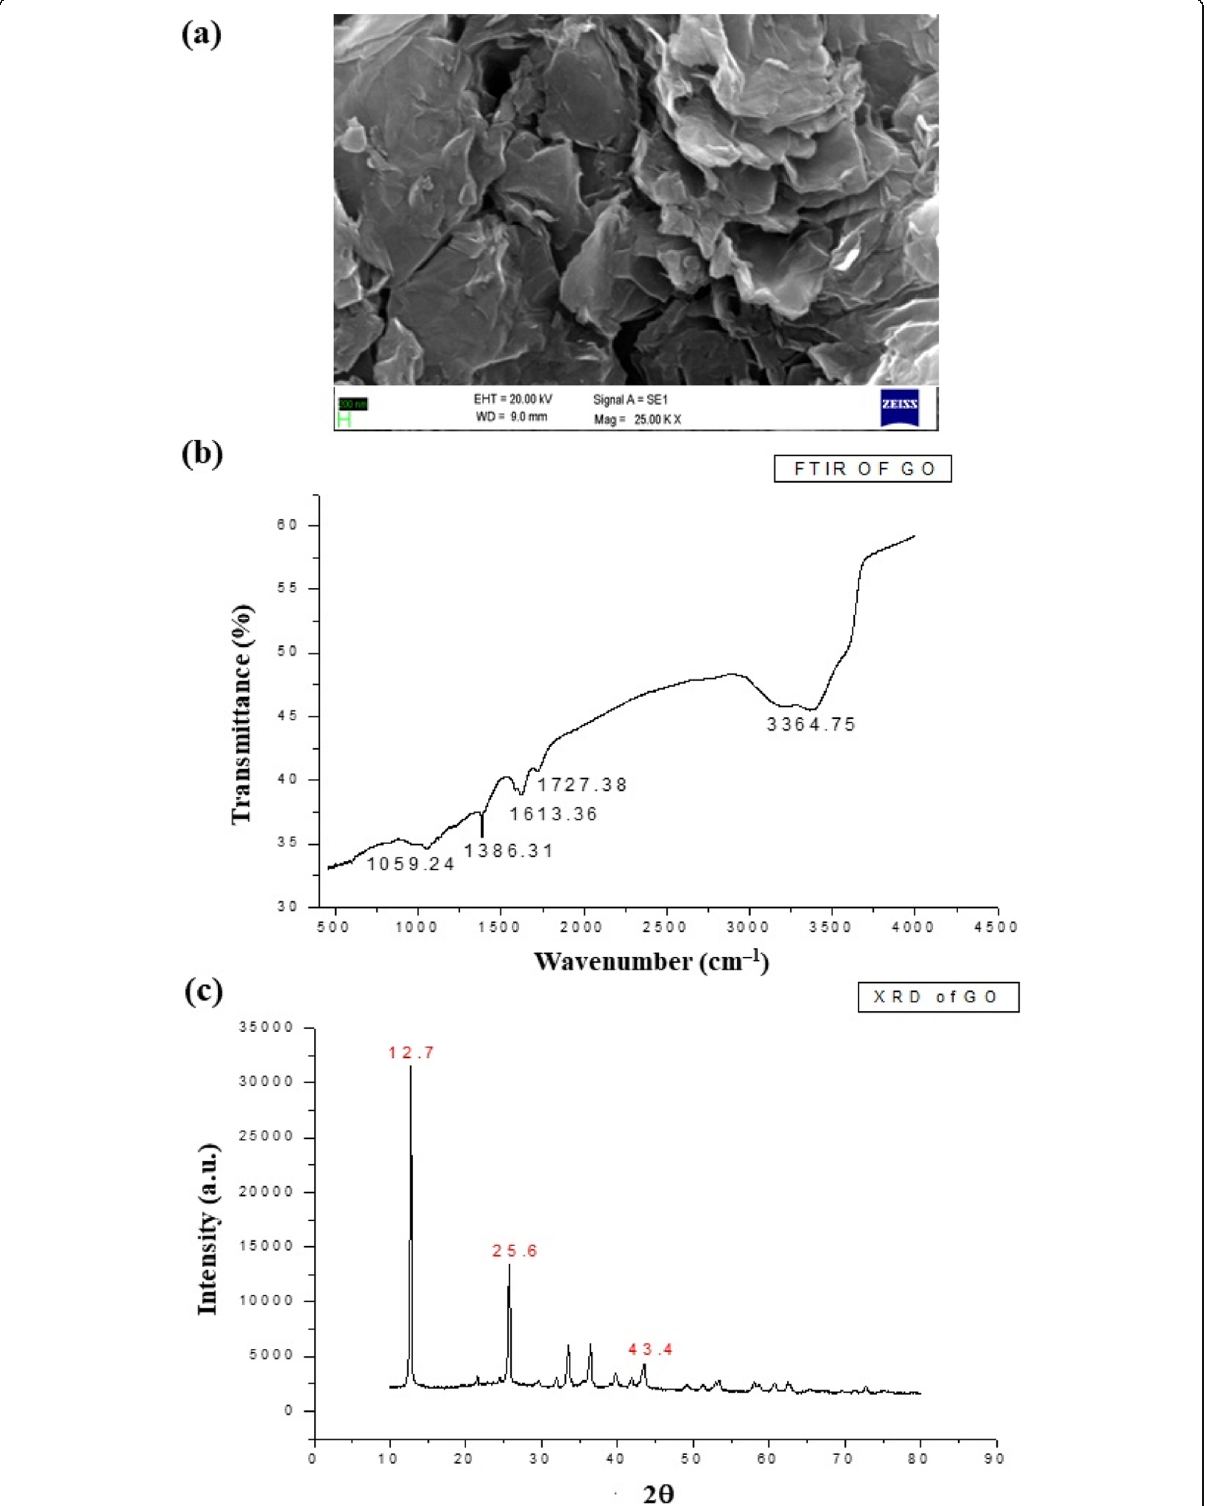
Fig. 2 Characterization of graphene oxide (GO). Plots ( a – c ) show the SEM image, the FTIR spectrum and the XRD spectrum of GO used in this study